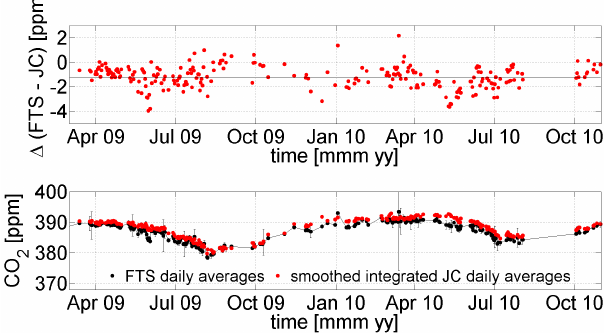
Fig. 7. Upper panel: the difference between the Białystok FTS daily averages and the corresponding integrated model data. The black line indicates the mean difference. Bottom panel: The daily averages of the integrated model data of the Jena CO 2 inversion in comparison with the daily averages of the FTS time series (1 σ standard deviation as error estimation).